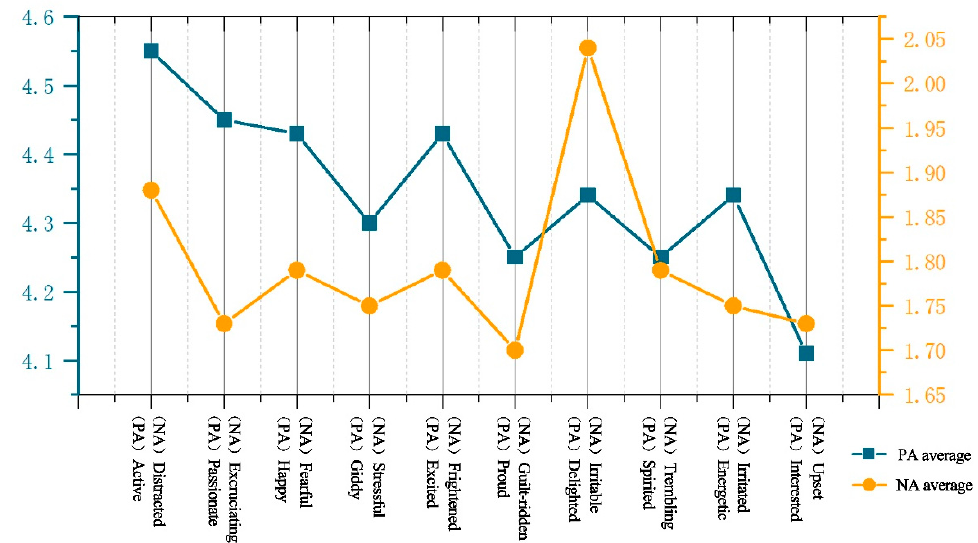
Figure 11. PANAS change trend chart. Source: After the experiment, the participants filled in the scale according to their own feelings of roaming the landscape experience, and the positive emotional adjective score ranged from 4.11 to 4.55 points, and the negative emotional adjective score ranged from 1.73 to 1.88 points.